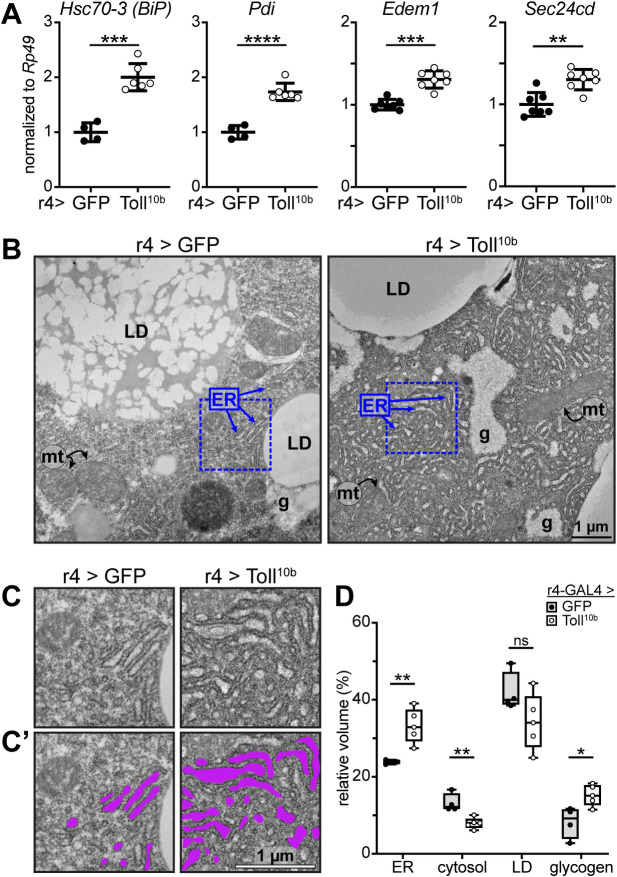
Chronic fat body Toll signaling leads to expansion of the endoplasmic reticulum.(A) Late third instar fat body levels of Hsc70-3 (BiP), Pdi, Edem1, and Sec24cd were measured by RT-qPCR and normalized to Rp49, n = 4-8/group. **p = 0.0012, ***p = 0.001, and ****p < 0.0001 versus GFP. (B) Electron micrographs of fat body cells expressing GFP (left) or Toll10b (right) under control of r4-GAL4. ER, endoplasmic reticulum; LD, lipid droplet; g, glycogen; mt, mitochondria. Dashed blue lines show areas enlarged in (C and C’). Scale bar, 1 μm. (C) Insets of electron micrographs outlined in blue dashed boxes in (B). (C’) Insets with ER structures highlighted in purple. Scale bar, 1μm. (D) Stereological analysis of organelle- and feature-specific volume density. Data points represent the average of volume densities measured from 5–15 images from a single fat body, n = 4–5 fat bodies/group. *p = 0.0175 and **p ≤ 0.0044 versus GFP. Data are presented as means ± SD. p values were determined by Student’s t test (A,D).